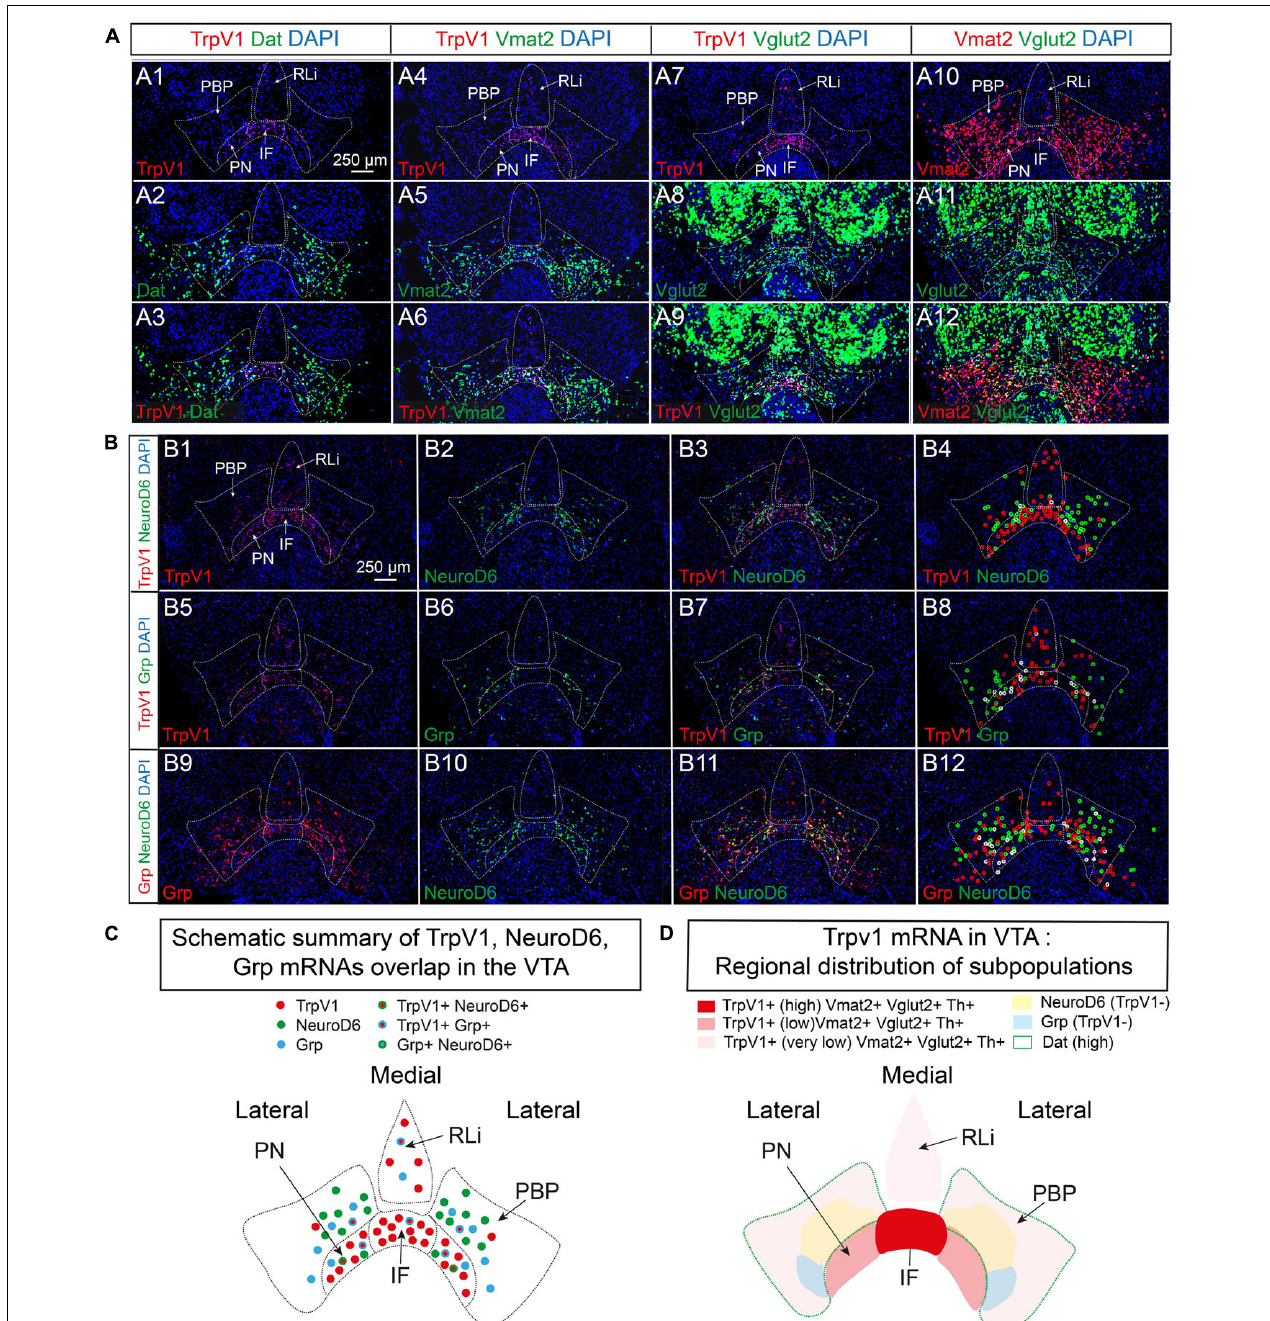
FIGURE 3 | TrpV1 mRNA forms a unique distribution pattern in the medial VTA and co-localizes strongly with Vmat2 but not with Dat, NeuroD6, or Grp mRNAs. (A,B) Fluorescent in situ hybridization (FISH) was analyzed in coronal VTA sections at postnatal day 3 (P3). DAPI is used for the detection of cell nuclei. (A) Left panel: TrpV1 (A1) , Dat (A2) , TrpV1/Dat (A3) . A left-middle panel: TrpV1 (A4) , Vmat2 (A5) , and TrpV1/Vmat2 (A6) . A right-middle panel: TrpV1 (A7) , Vglut2 (A8) , and TrpV1/Vglut2 (A9) . A right panel: Vmat2 (A10) , Vglut2 (A11) , and Vmat2/Vglut2 (A12) . (B) A top panel: TrpV1 (B1) , NeuroD6 (B2) , TrpV1/NeuroD6 (B3) , TrpV1/NeuroD6 ( B4 , positive cells encircled). A middle panel: TrpV1 (B5) , Grp (B6) , TrpV1/Grp (B7) , TrpV1/Grp ( B8 , positive cells encircled). A bottom panel: Grp (B9) , NeuroD6 (B10) , Grp/NeuroD6 (B11) , and Grp/NeuroD6 ( B12 , positive cells encircled). Red circles label the red fluorophore, green circles label the green fluorophore, white circles label co-labeling both fluorophores. (C) A schematic summary of results obtained in (B) outlining TrpV1-positive cells and co-labeling (or its absence) TrpV1, Grp, and NeuroD6 mRNAs in the VTA. (D) A schematic summary of results obtained in (A,B) , and Figure 1 , outlining the main distribution of areas positive for TrpV1 mRNA and co-labeling (or its absence) with Th, Vmat2, Vglut2, Dat, NeuroD6, and Grp mRNAs in the VTA. Scale bars, 250 µ m. See Table 1 for cell counting. IF, interfascicular nucleus; PN, paranigral nucleus; PBP, parabrachial pigmented nucleus; RLi, rostral linear nucleus; VTA, ventral tegmental area.